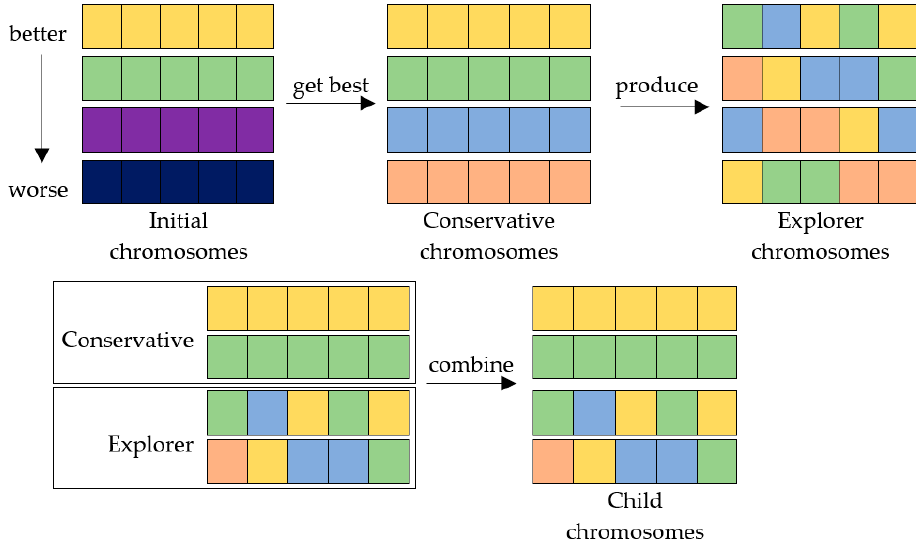
Figure 4. Selection operators for MSGAs.